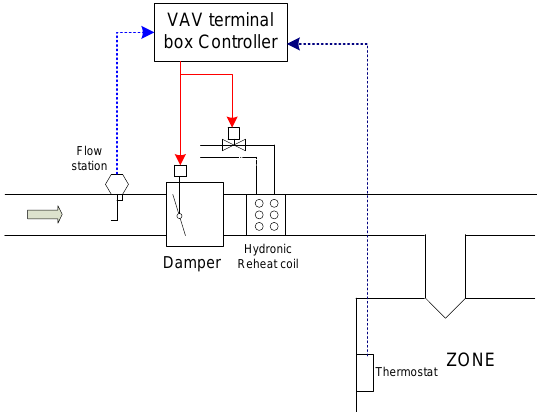
Figure 1. Schematic diagram of a single-duct VAV terminal